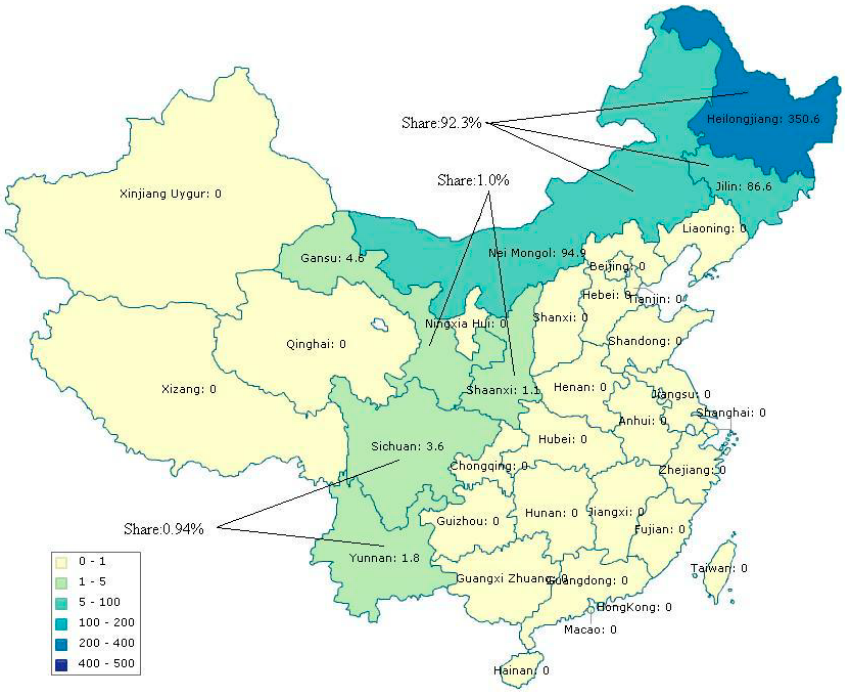
Figure 1. Proportions of gross domestic product (GDP) of key state-owned forestry enterprises in three major regions. Table 1. Malmquist data envelopment analysis (DEA)–based system of evaluation indices of production efficiency.